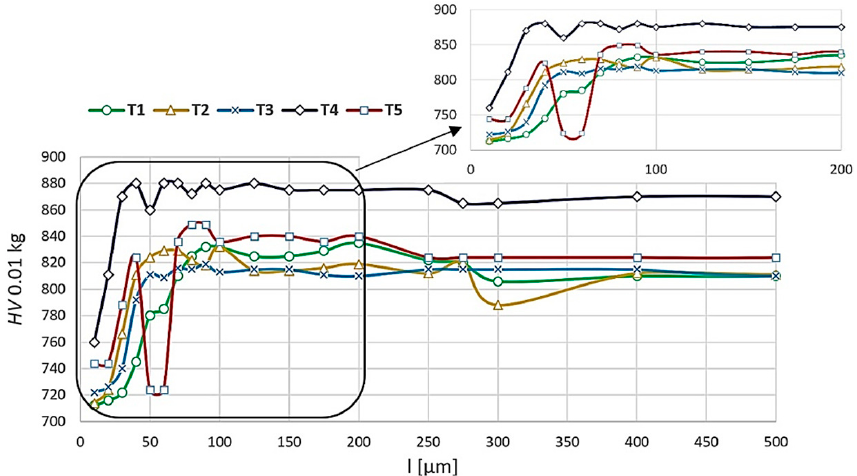
Figure 9. Microhardness of the material processed with the feed f 3 = 0.3 mm/rev. depending on the tested tool where: T1–T5—tool type.